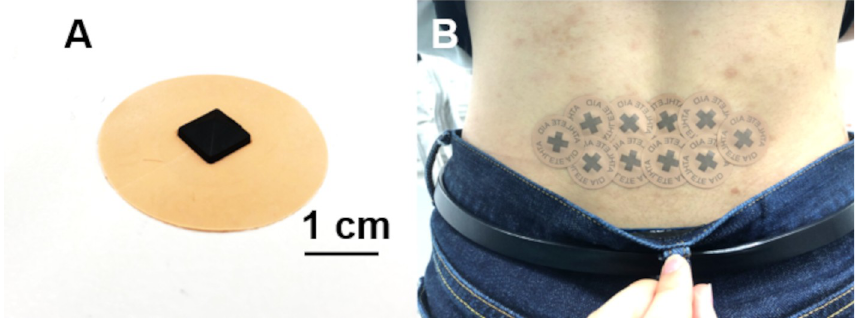
Fig 1. Pyramidal thorn patch. A . The pyramidal thorn patch has a diameter of 3 cm and a thickness of 0.1 mm, and the tapered pyramidal thorn made of low-density polyethylene is 3 mm high and a square with 7-mm sides. B . Application of pyramidal thorn patches to the pain region ( e . g ., lower back). After palpating to determine the pain region, several pyramidal thorn patches were applied to alleviate